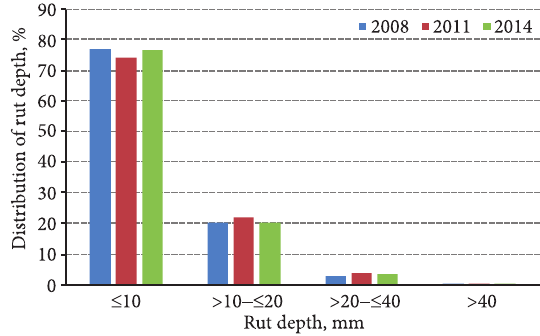
Fig. 4. Distribution of rut depth in main roads of Lithuania